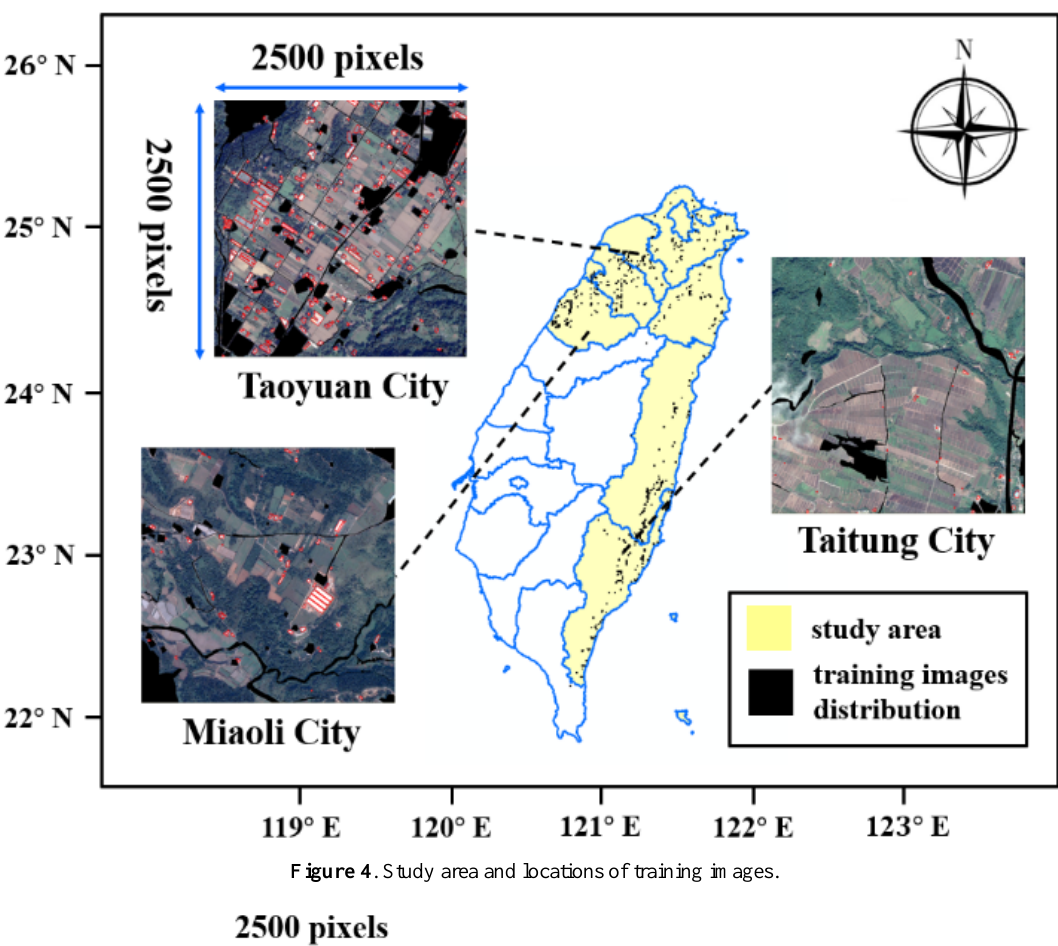
Figure 4 . Study area and locations of training images.